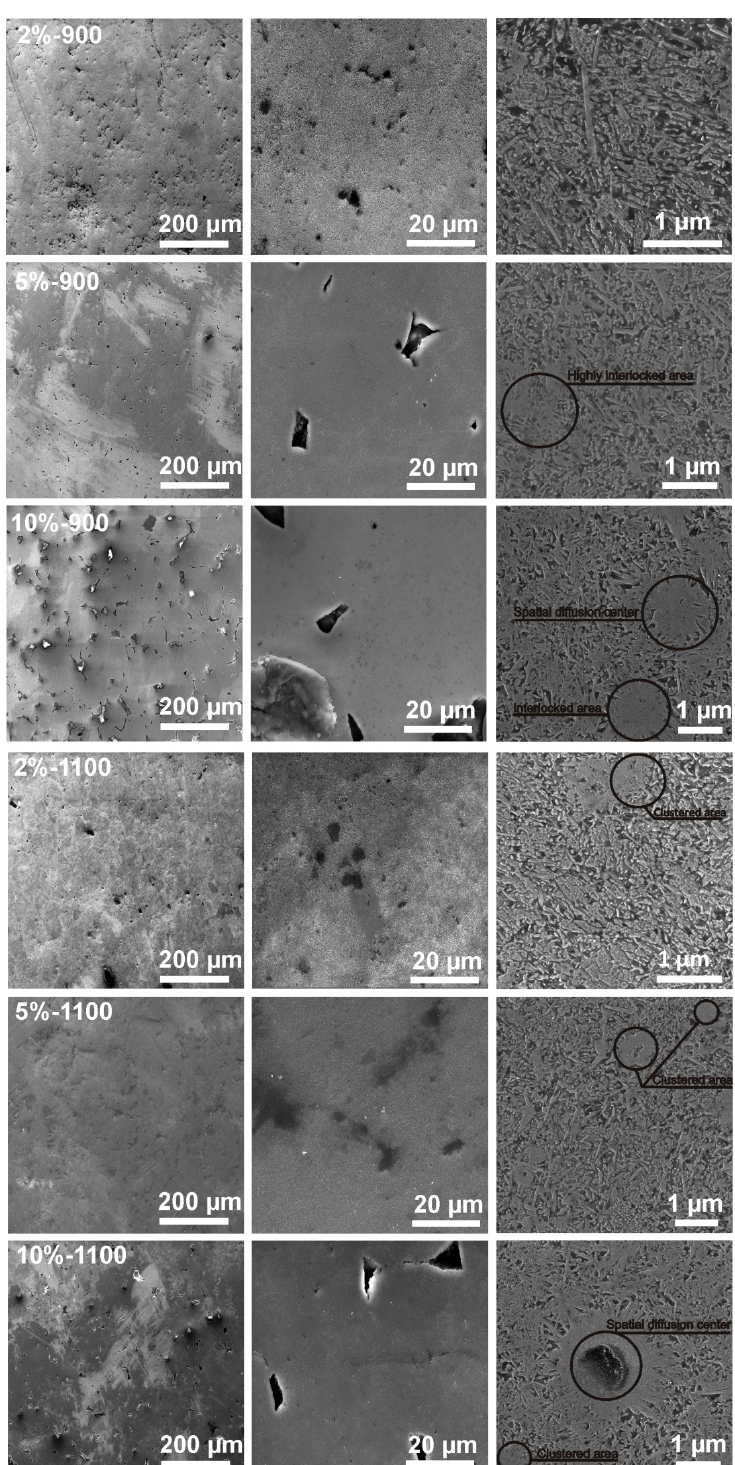
Figure 7. SEM microphotographs of the sinters obtained at different processing temperatures and from different starting precursor compositions (etched and non-etched